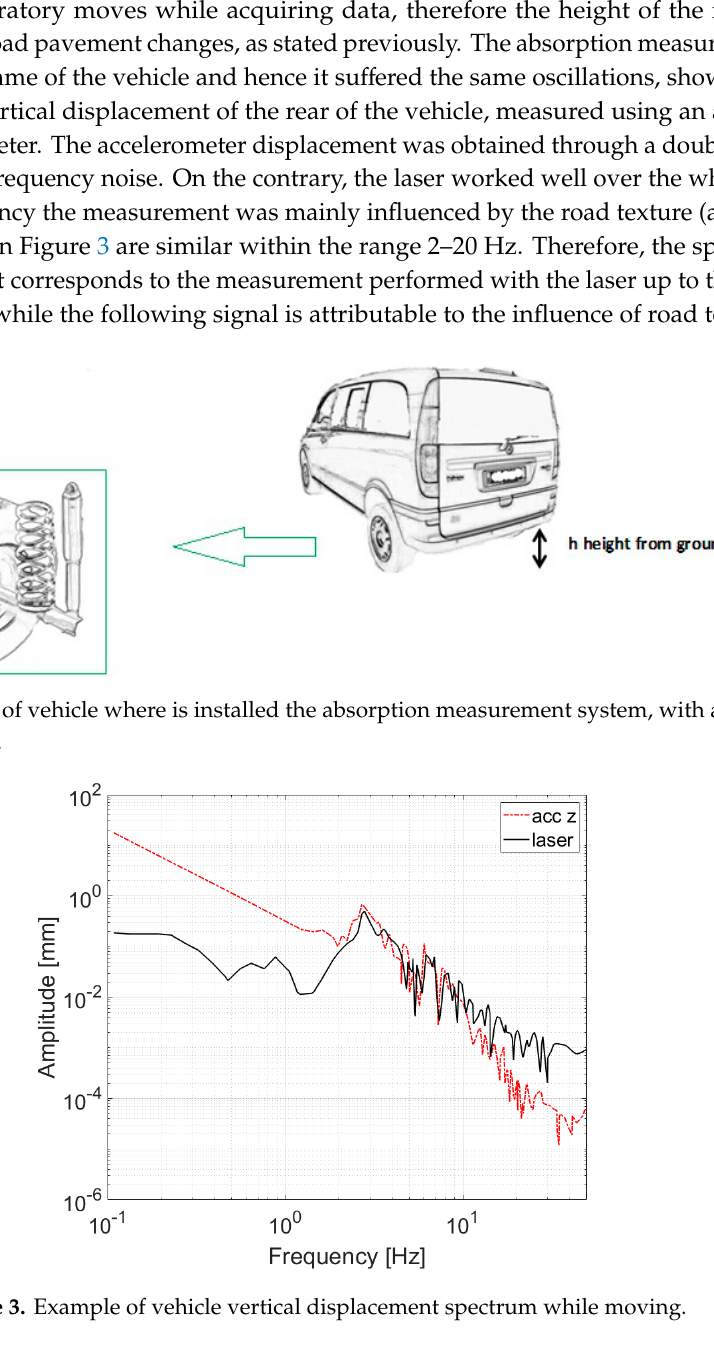
Figure 3. Example of vehicle vertical displacement spectrum while moving.